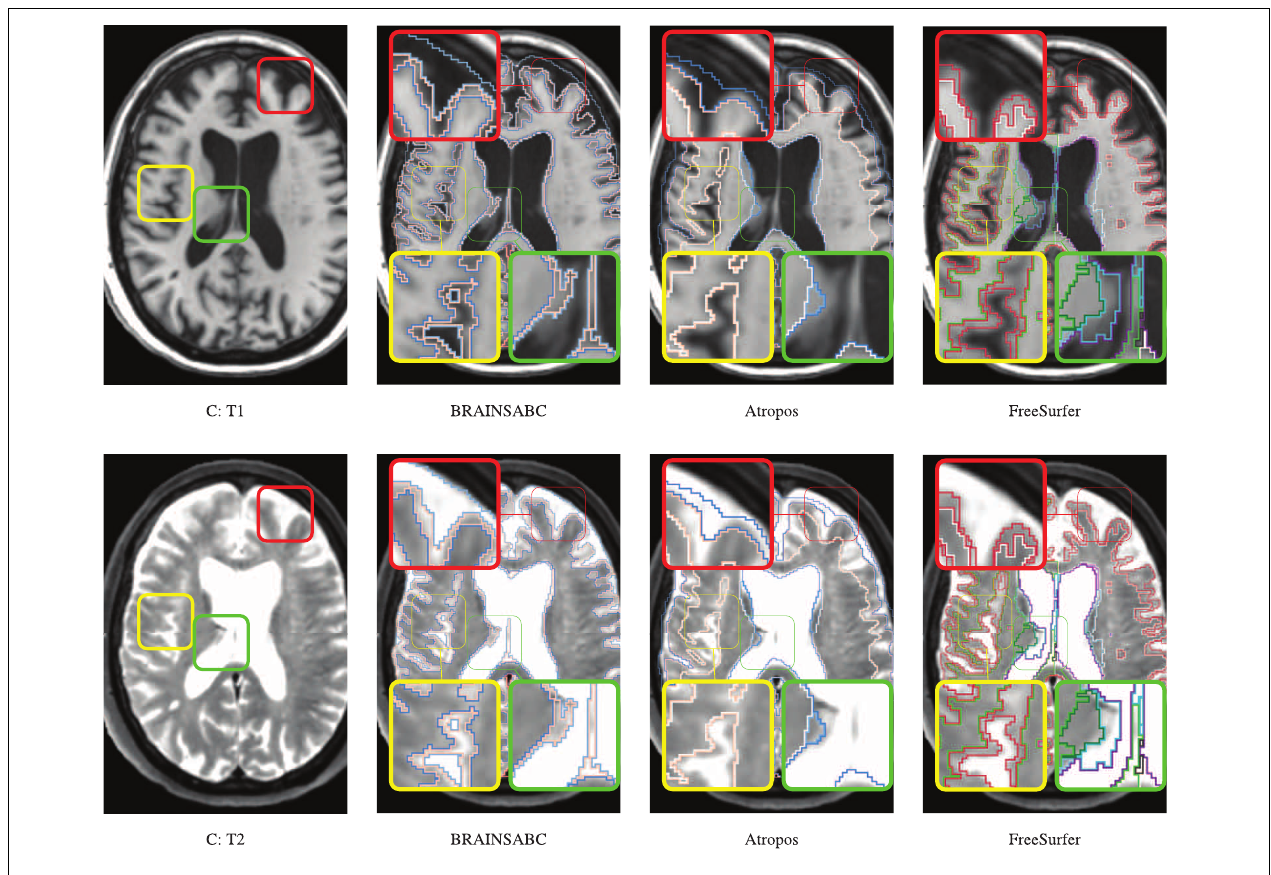
FIGURE 6 | Visual Comparison of Scan C in Table 2. Tissue classification results from three applications, BRAINSABC, Atropos of ANTS Tools, and FreeSurfer on top of T1- and T2-weighted images, multi-modal processing. This subject present relatively small tissue ratio, reflecting brain atrophy progression to some extent. BRAINSABC and other two methods produced very similar results in this scan. Differences between methodologies are also observed as highlighted in red, yellow, and green boxes. Red box contrasts